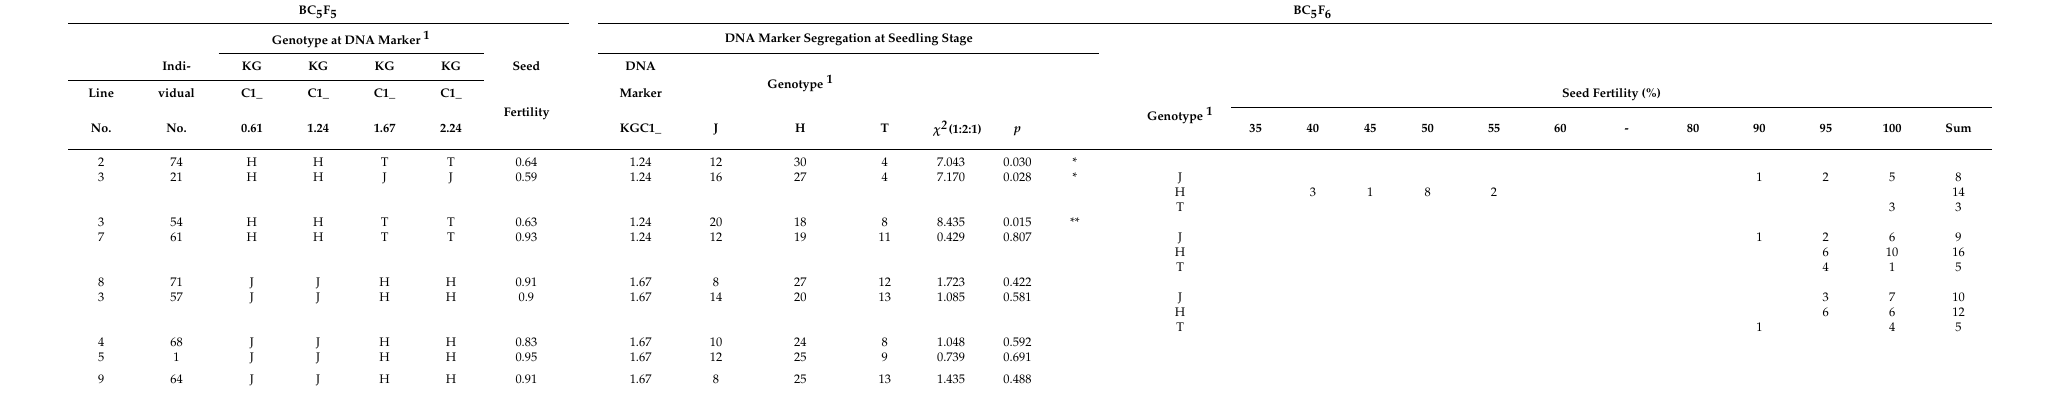
Table 4. Segregation of DNA markers of the progeny of the recombinants between KGC1_1.24 and KGC1_1.67 in BC 5 F 5 and BC 5 F 6 generation. BC5F5